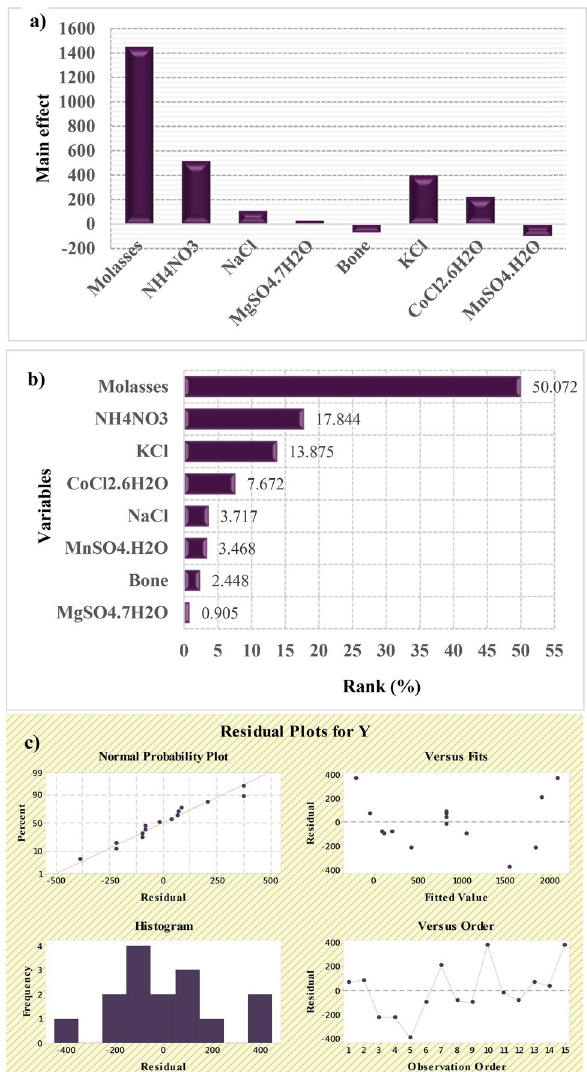
Figure 3. Results obtained from the Plackett–Burman design (PBD): ( a ) main culture variables, ( b ) Pareto chart illustrating the order and significance of the variables affecting laccase production by Bacillus paralicheniformis strain APSO in a ranking percentage from 0.905 to 50.072, and ( c ) normal probability plot of the residuals for laccase production determined by the first-order polynomial